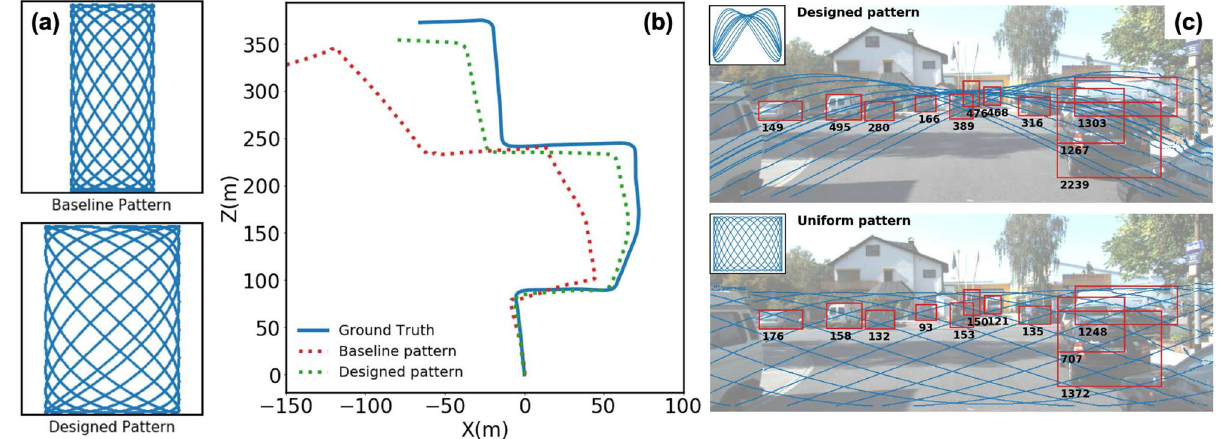
Figure 3. ( a ) Qualitative comparison of baseline and designed scanning patterns ( P 1 and P 2 in Fig. 1a). Scanning range of the designed pattern is 1.6 × of that in baseline pattern, leading to a larger perspective field and more reliable feature extraction. ( b ) Trajectory estimations with optimized scanning pattern and baseline scanning pattern. ( c ) Object detection with optimized pattern and baseline pattern. Each red bounding box contains an object and the black number at bottom indicates number of sampling points contained in the bounding box. Due to the RoI-focusing improvement, optimized pattern contains ∼ 3 × more sampling points in bounding boxes. The sampling patterns are shown in blue